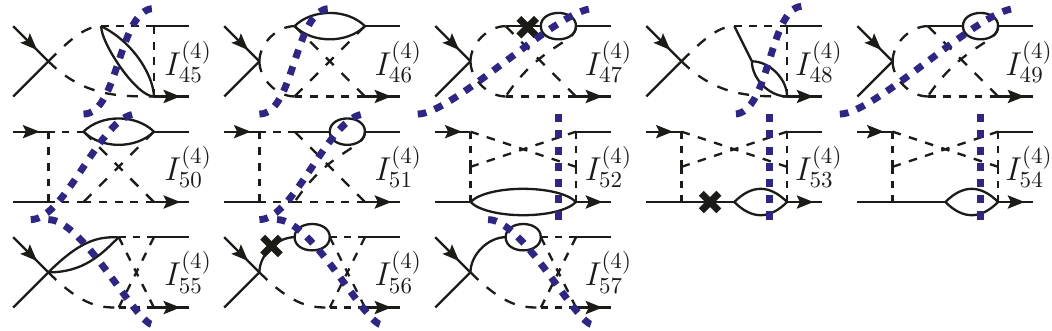
Figure 10 . Continuation of figure